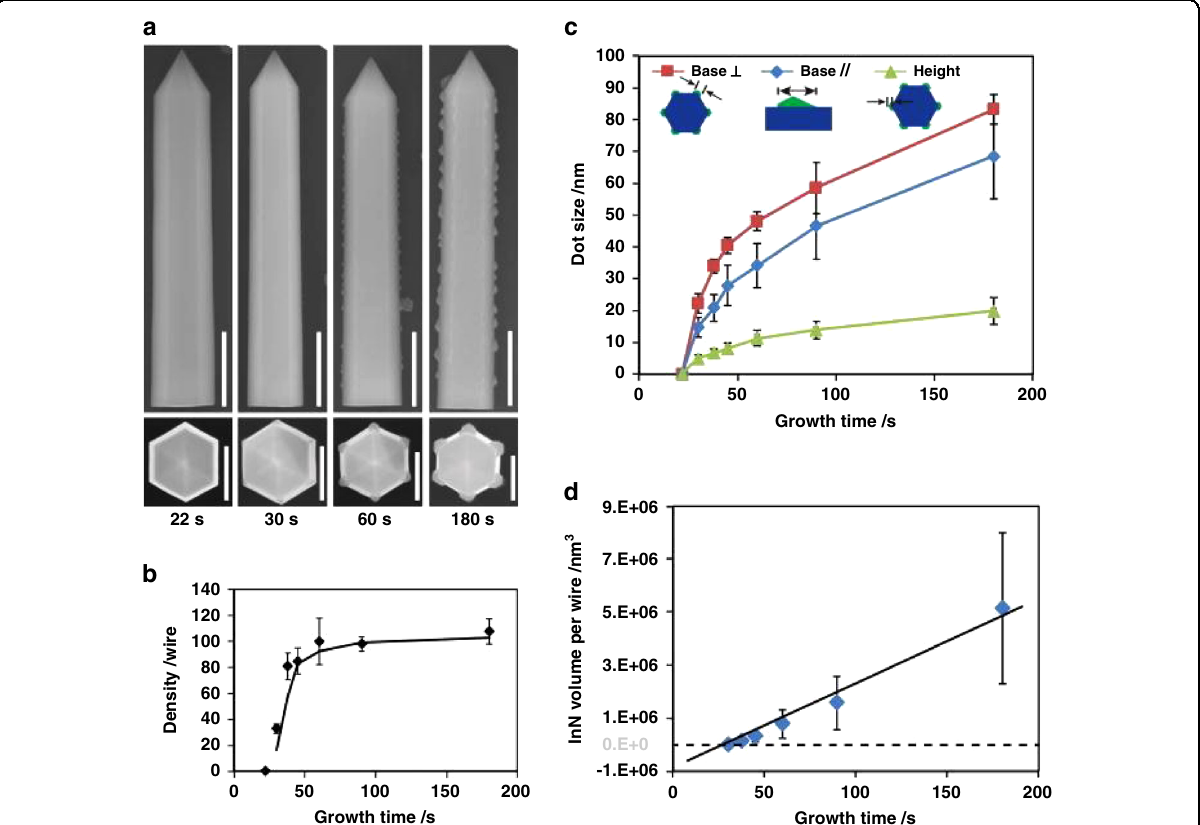
Fig. 6 InN QDs on GaN NWs at varying growth times. a SEM images of side (top) view with 500 nm scale bar and top (bottom) view with 250 nm scale bar. Plots of InN QD parameters versus growth time: ( b ) density per wire, ( c ) size, and ( d ) InN volume on each nanowire. Reprinted from Bi et al., J. Appl. Phys. 123 , 164302 (2018), with the permission of AIP Publishing